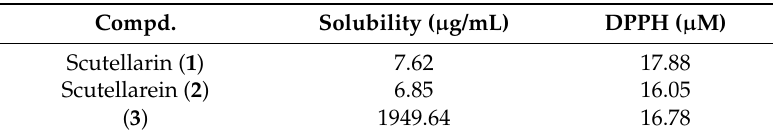
Table 1. The solubility in water and antioxidant activity of scutellarin ( 1 ), scutellarein ( 2 ), and 3 . DPPH: (1,1-diphenyl-2-picrylhydrazyl). Compd.